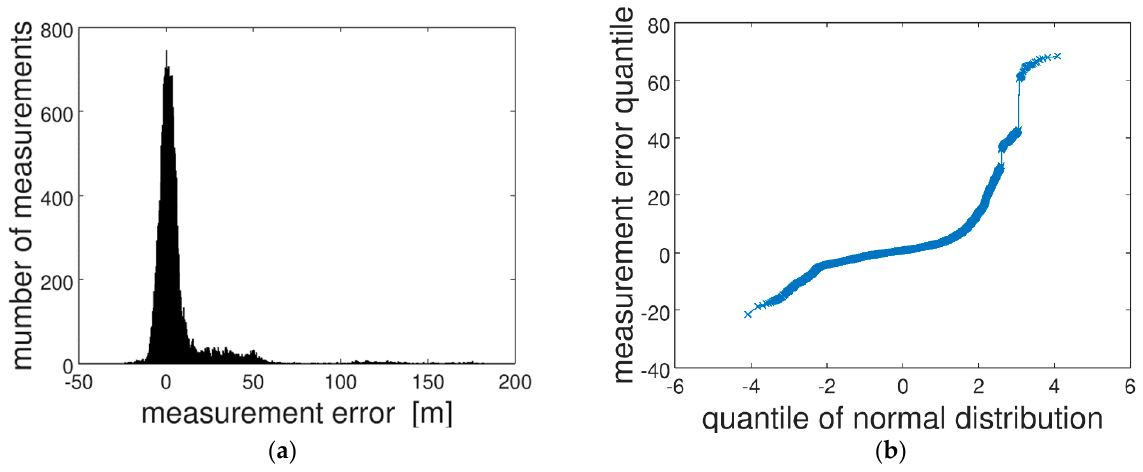
Figure 7. Histogram of raw position records in latitude (from the reference true position) ( a ) and the quantile–quantile plot as applied to raw position observation ( b ).